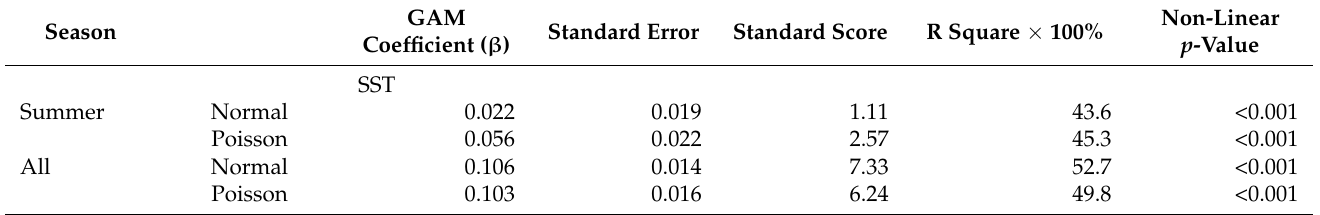
Table 4. GAM parameters showing temporal variations of SST, SSS, and Chl-a as response variables in relation to year as explanatory variable at the Kola Section in the Barents Sea during the period 1984–2021 using parametric (Normal) and non-parametric (Poisson) added